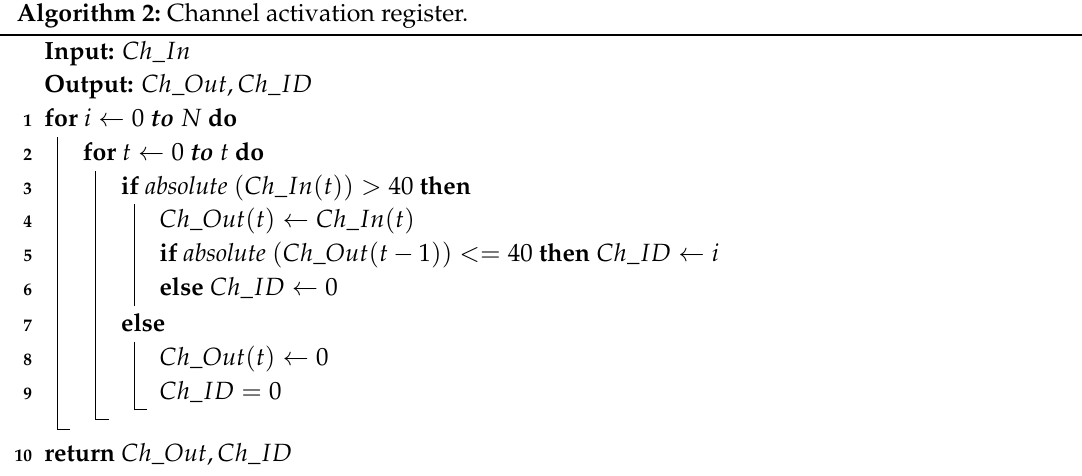
Figure 4. System architecture for a channel activation register unit with 2 input channels. Algorithm 2: Channel activation